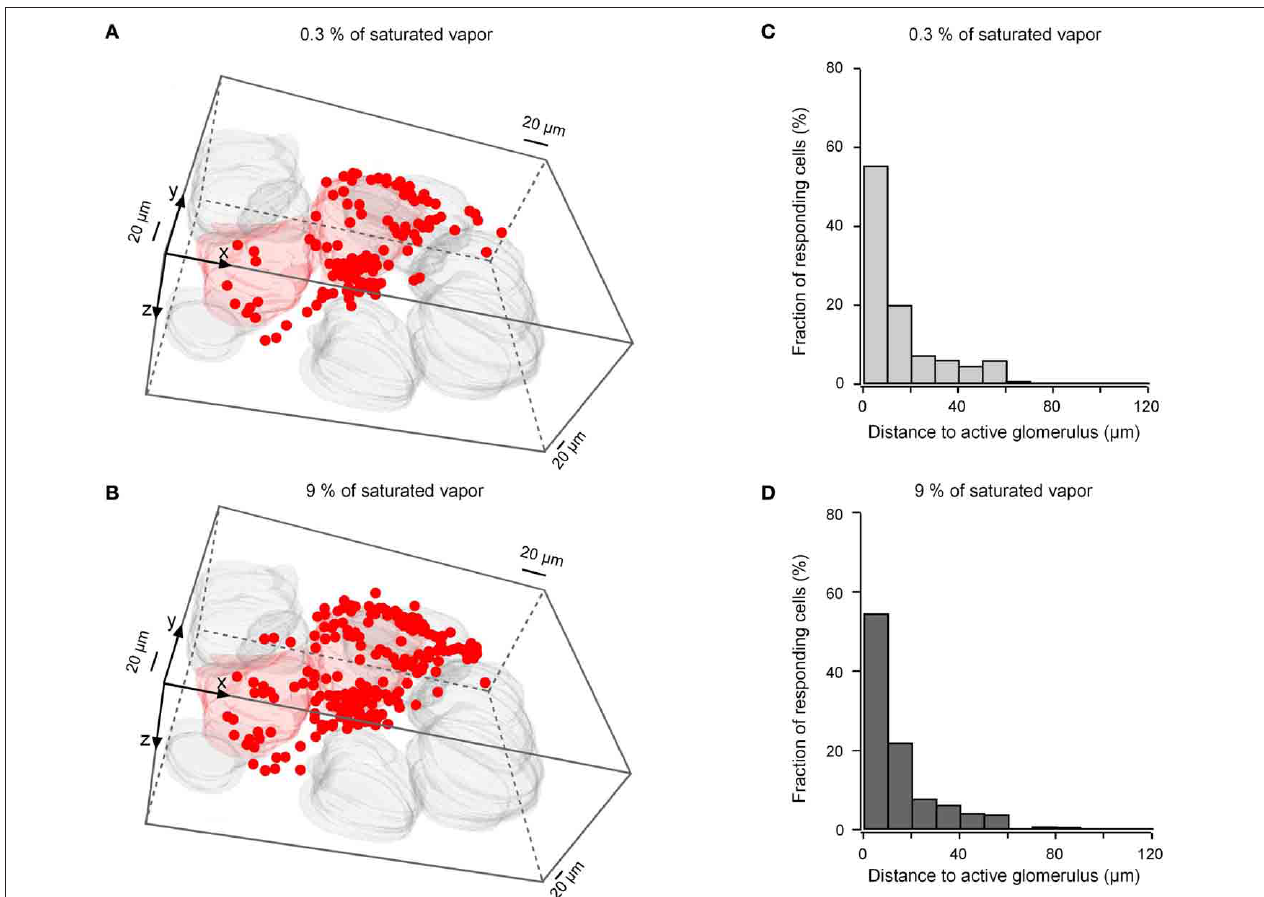
frame, we might have missed some ON cells surrounding this glomerulus. (C,D) Histograms summarizing the position of ON neurons at the two different odorant concentrations with respect to the three-dimensionally nearest ON glomerulus [ n = 251 cells in (C) and n = 489 cells in (D) , five